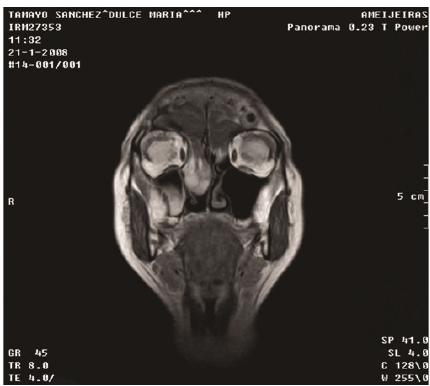
Figure 1: MRI, coronal view.